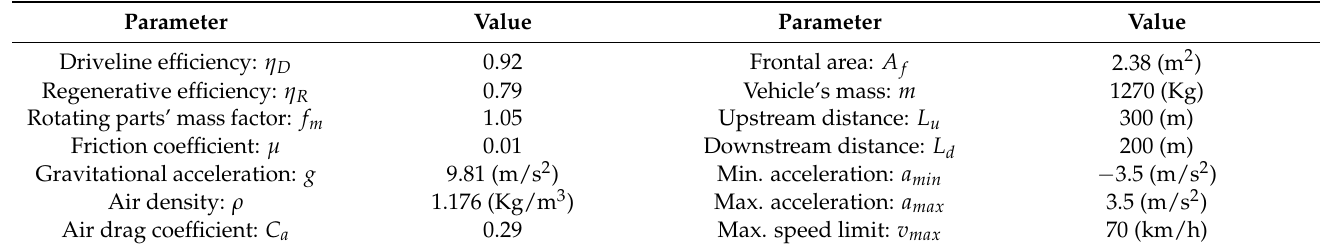
Table 2. Parameter values of measurements.